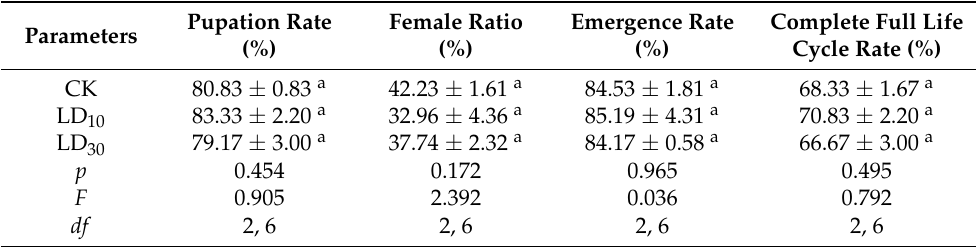
Table 9. Sublethal effect of fluxametamide on biological parameters of F 1 C. suppressalis pupae and adults.